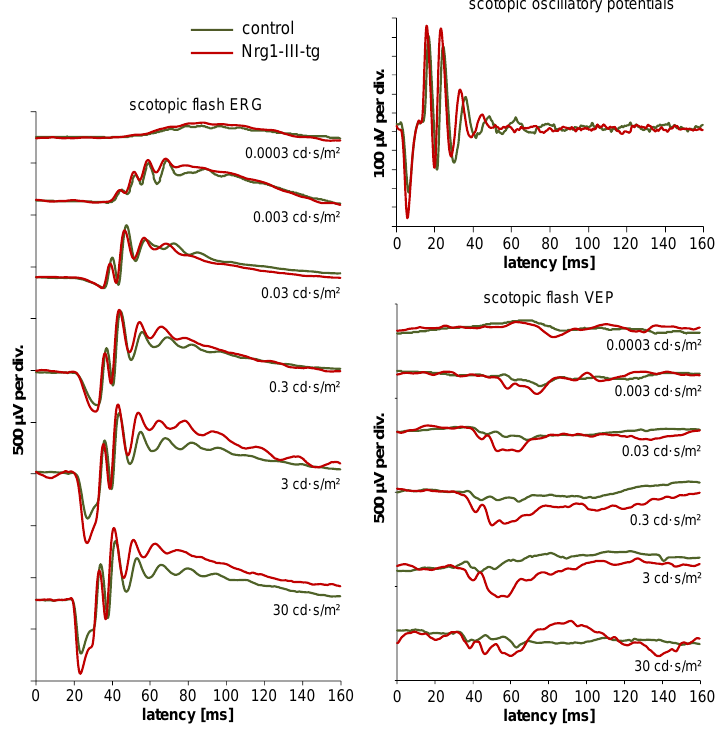
Figure 3. Typical waveforms of ERG and VEP measurements in 12-week-old control and transgenic mice.